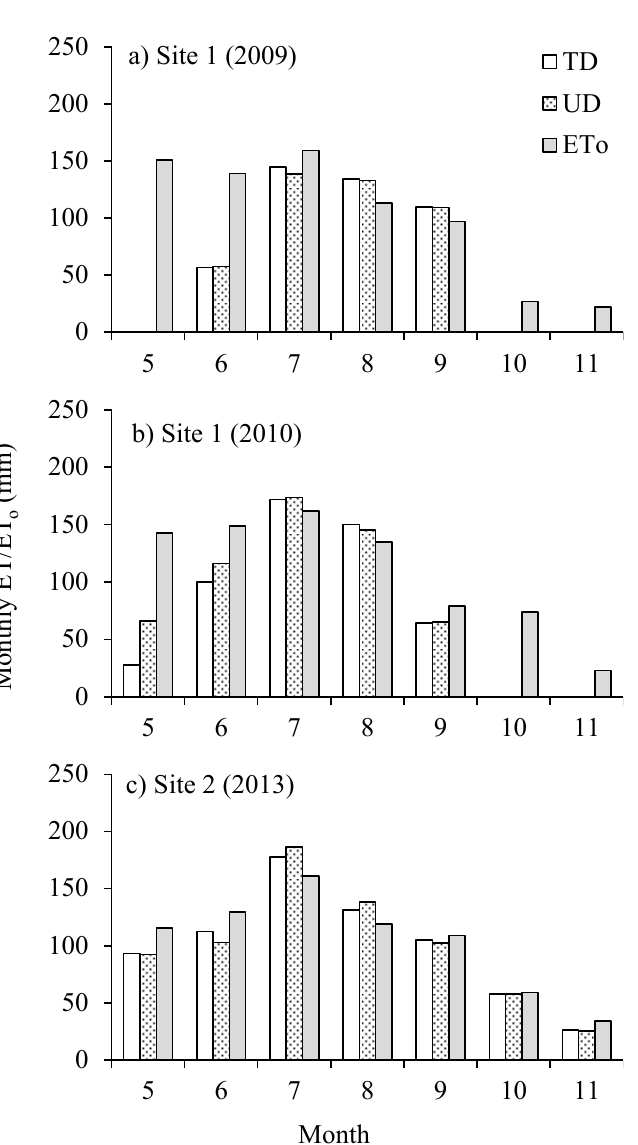
Figure 6. Monthly ET from the subsurface drained (TD) and undrained (UD) fields estimated using METRIC, and monthly ET o estimated from weather data during the study years at ( a , b ) Site 1 and ( c ) Site 2.